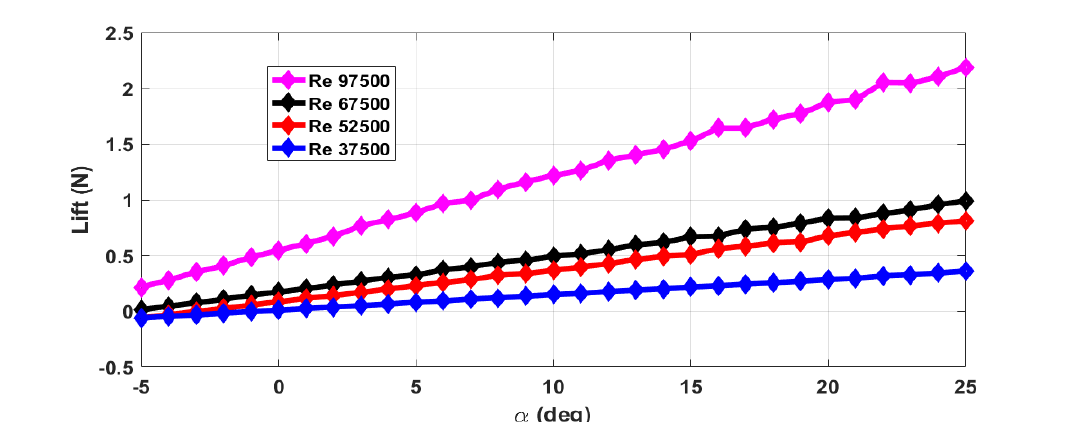
Figure 7. Lift force for zero elevator deflection and a propeller RPM of 8000.